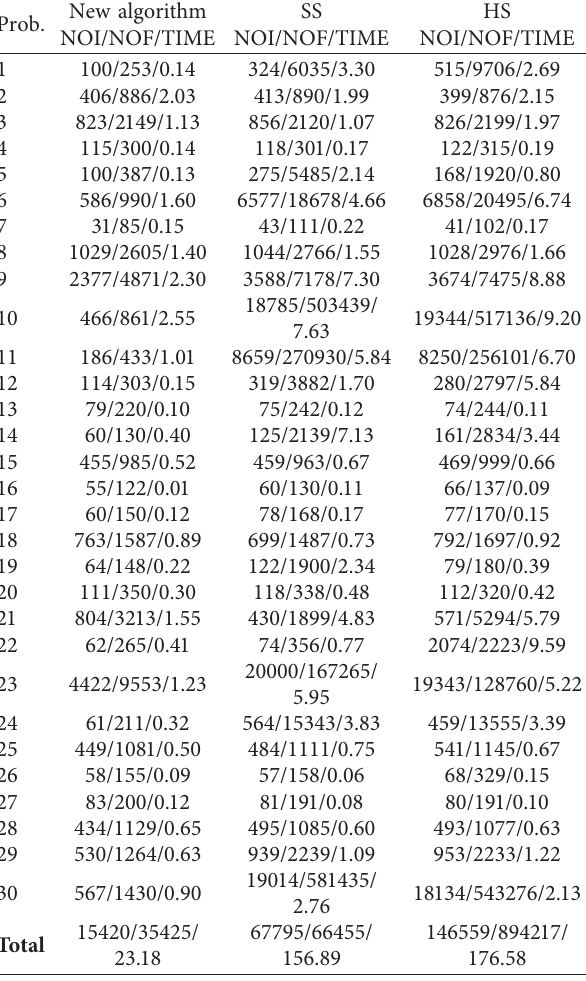
Table 1: Comparisons of the new algorithm against SS and HS algorithms for a total of 30 test problems.